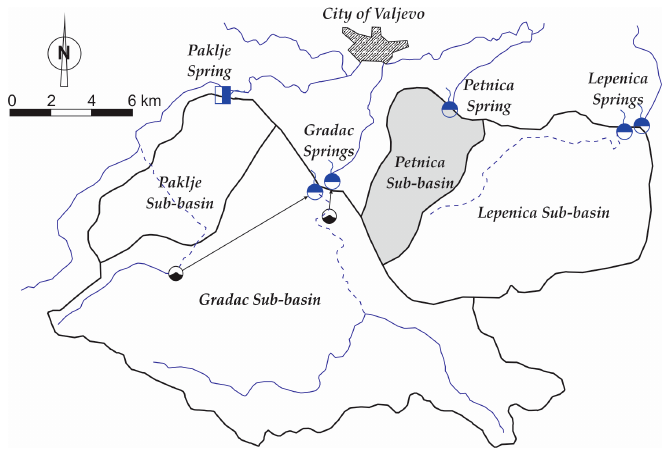
Figure 3. Boundaries of sub-basins within “Leli ć ki karst” structure (based on [8],